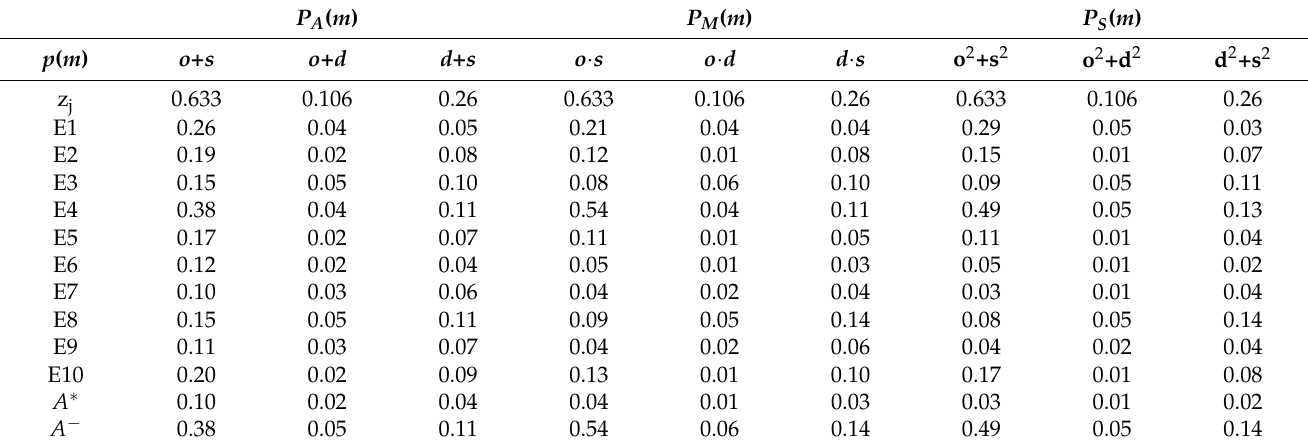
Table 6. Normalized and weighted decision matrix.